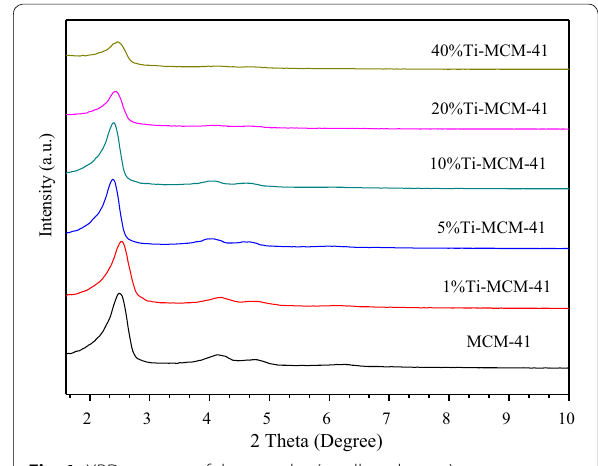
Fig. 1 XRD patterns of the samples (small angle